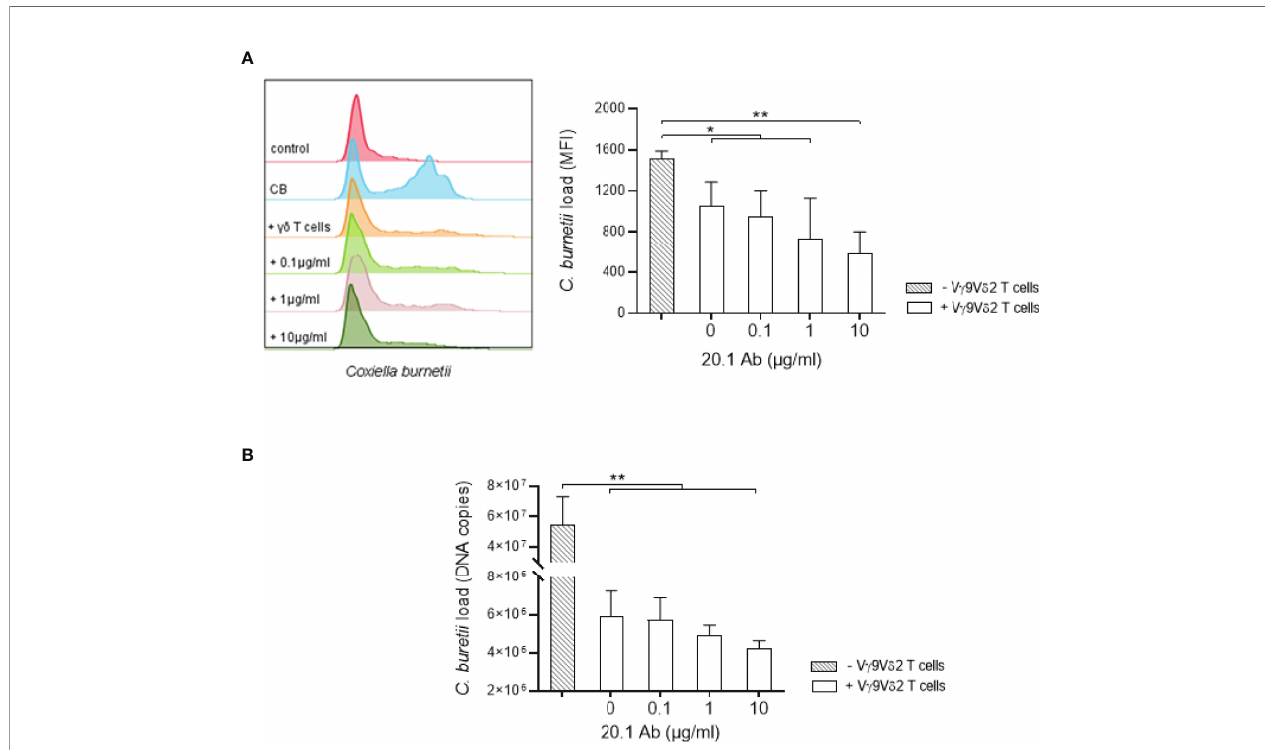
FIGURE 5 | Anti-BTN3A agonist antibody increases antimicrobial activity of V g 9V d 2 T cells towards C. burnetii infected monocytes. (A, B) Monocytes isolated from healthy donors (n = 4) previously infected 24 hours with C. burnetii NM1 (50 MOI) were co-cultured with autologous V g 9V d 2 T cells (E:T ratio of 1:1) in the presence of anti-BTN3A antibody (clone 20.1) (0-10 µg/ml). After 4 hours of co-culture, C. burnetii load was measured by (A) fl ow cytometry and (B) qPCR. Data were analyzed using a normality test and a parametric t test. Values represent mean ± standard deviation. * p < 0.05 , ** p < 0.01